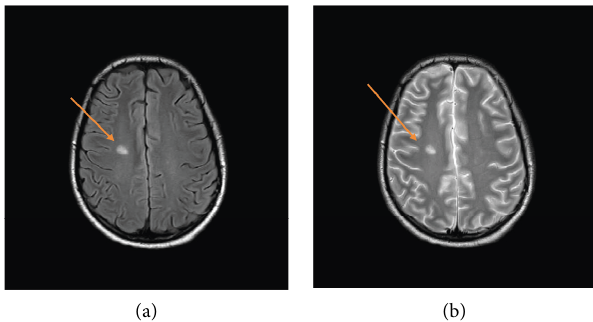
Figure 4: Flair MR image showing high signal intensity (left image orange arrow) and corresponding T2-weighted image showing an area of high signal intensity (right image orange